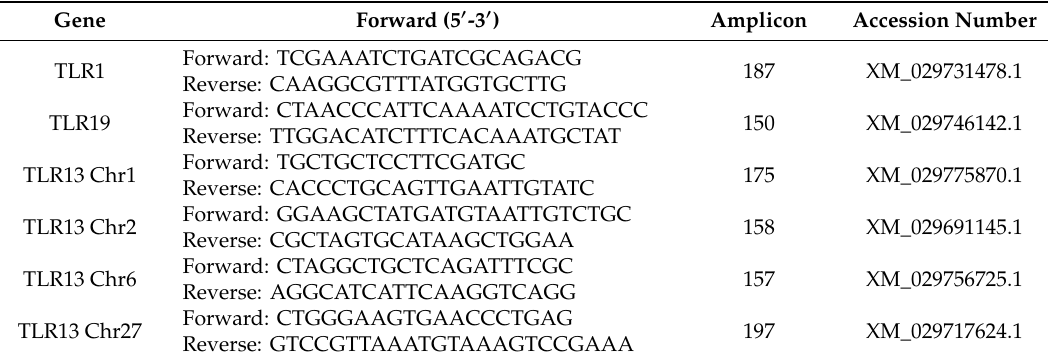
Table 2. List of quantitative qRT-PCR primers designed in this